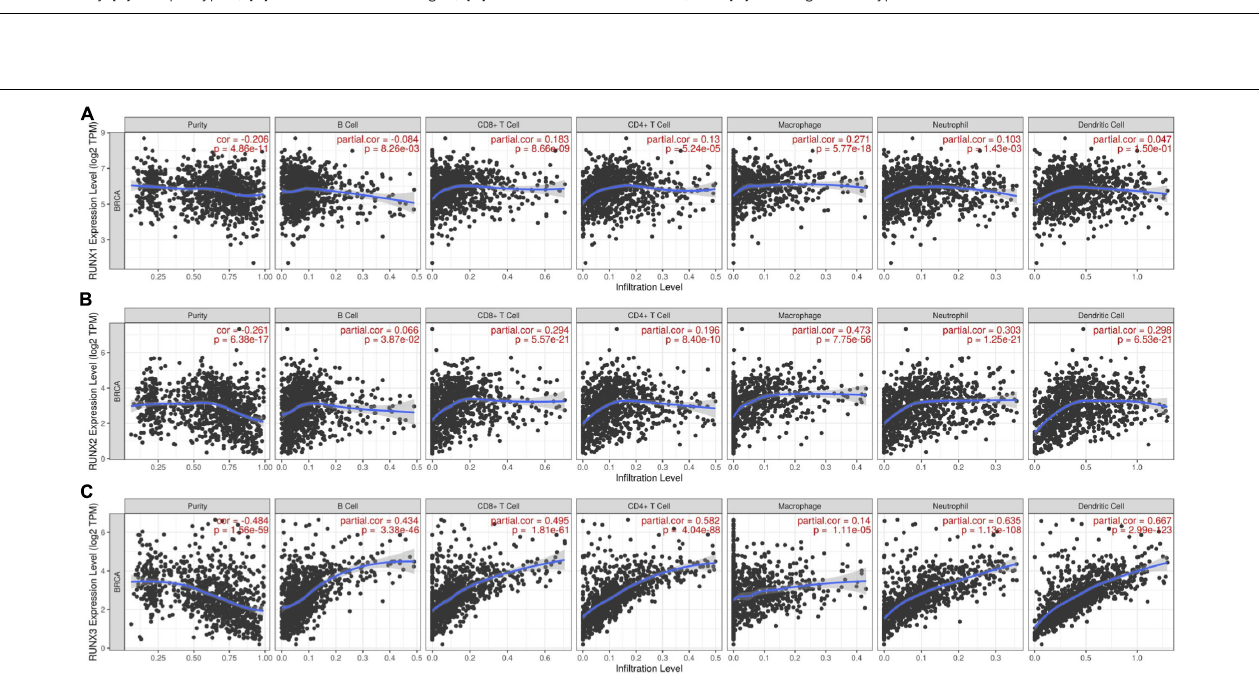
FIGURE 9 | Correlation analysis between RUNX3 methylation level and breast cancer patient characteristics. The RUNX3 methylation level in breast cancer patients classified by (A) sample types, (B) individual cancer stages, (C) breast cancer subclasses, and (D) histological subtypes were shown.